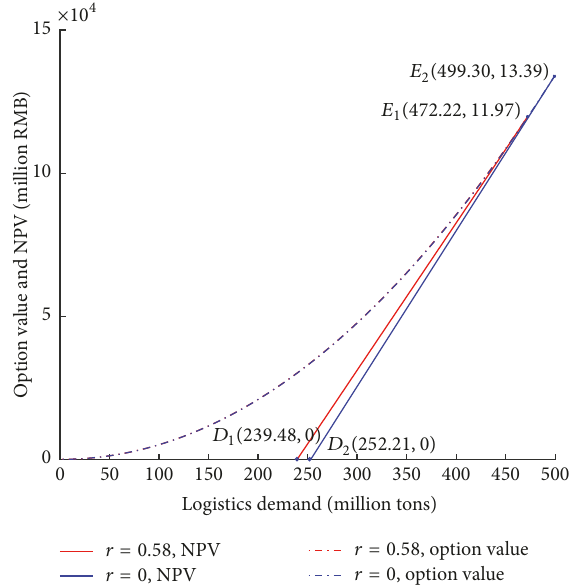
Figure 1: Option value curves and NPV value curves with different government subsidies.